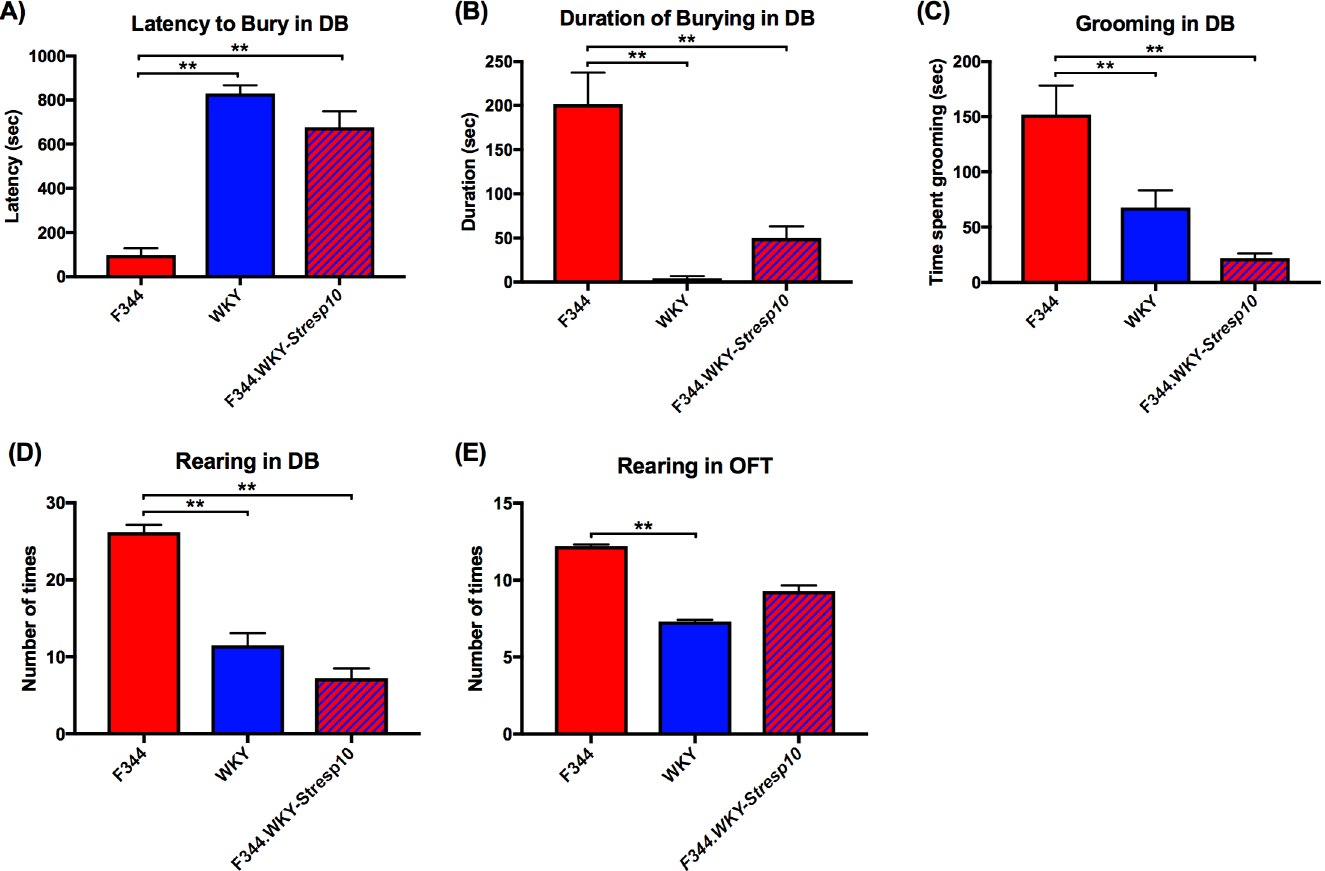
Fig 2. Phenotypic differences between the F344, WKY, and F344.WKY- Stresp10 strains in the defensive burying and open field tests. (A, B) Both WKY and F344. WKY- Stresp10 adult male rats exhibited significantly longer latency to bury and shorter duration of burying the electrified prod compared to the F344s. (C, D) Both WKY and F344.WKY- Stresp10 rats groomed less (time spent grooming in seconds) and reared less compared to the F344s in the DB paradigm. (E) WKYs also rear significantly less than F344s in the OFT, while the number of rearing of F344.WKY- Stresp10 did not differ significantly from either parental strain. Data are presented as mean ± standard error of mean. N = 13–18 per group. (cid:3)(cid:3) P < 0.01 by two-way ANOVA followed by Bonferroni’s multiple comparisons test.